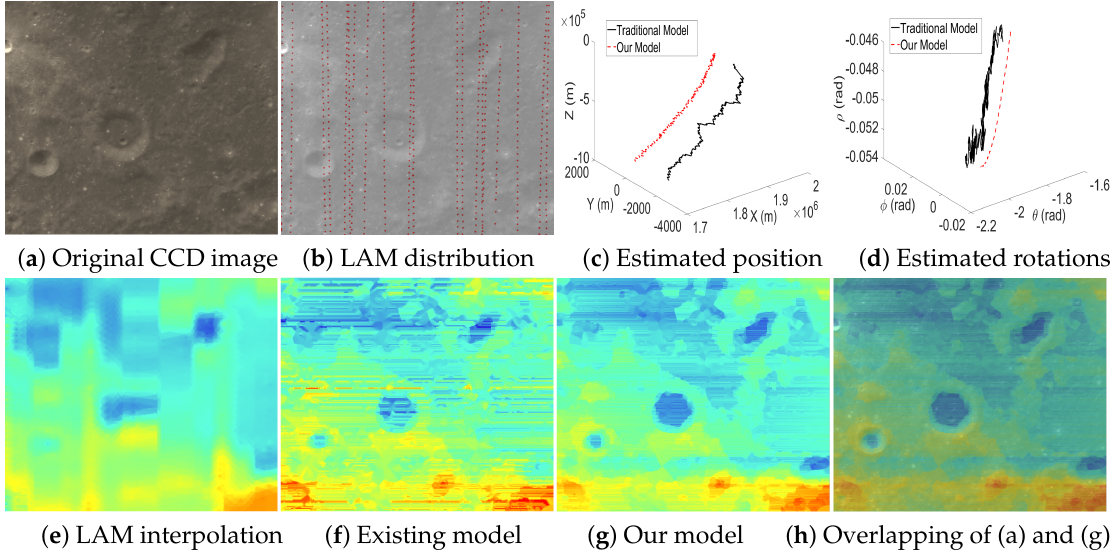
Figure 13. Case 3 with a sparse LAM distribution.